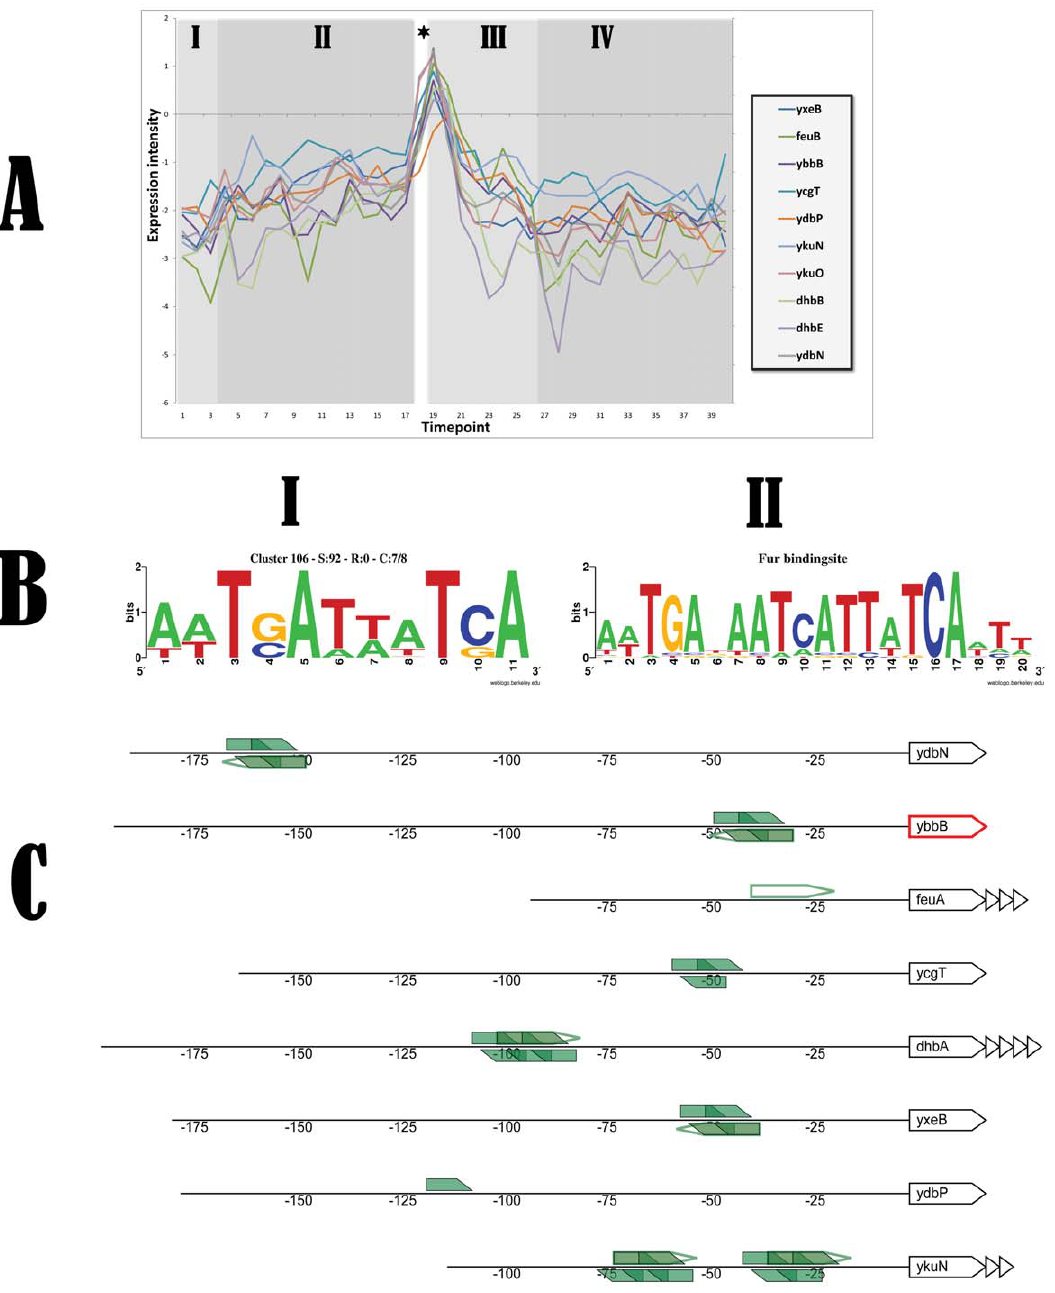
Figure 3. Information for cluster 106 obtained by a K-means clustering analysis using 189 clusters. The most overrepresented DNA binding site was identified in the upstream regions of the operon members of this cluster. A) Expression graph of the members of cluster 106. B.I) Most overrepresented motif that was identified in 7 out of 8 operons of the cluster. B.II) The most overrepresented motif from B.I shows high similarity with the known DNA binding site of Fur. C) Visualization of the genomic context of putative and known motifs in the upstream sequences of the operons. Open polygons represent known binding sites derived from literature sources. Filled polygons depict putative motifs, numbers represent the upstream region. The first gene of the operon is displayed; remaining members of this operon are visualized as triangles. Genes coding for a putative regulator are colored red.